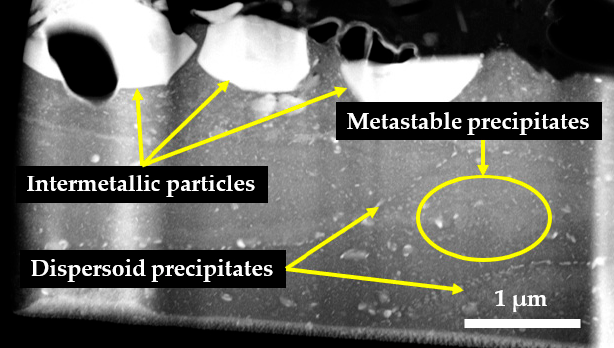
Figure 2. STEM lamella of aluminum alloy 7475-T7351—occurrence of secondary phases.